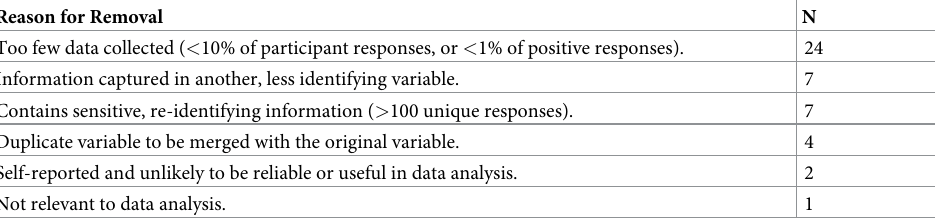
Table 3. Reasons for removal of quasi-identifiers from the de-identified data sets (N =